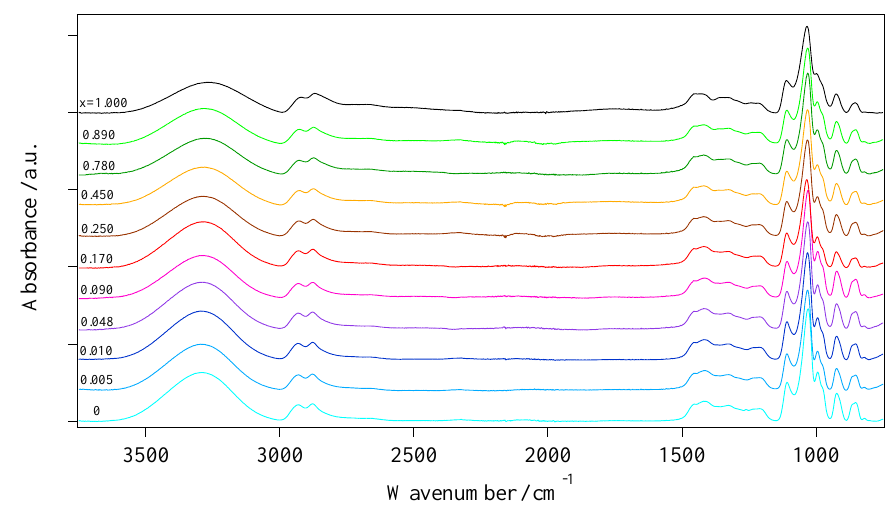
Figure 3. FT-IR spectra of GlyLi x electrolytes. Table 2. FT-IR and Raman correlational assignments of glycerol (Gly) and lithium glycerolate (GlyLi) samples. Glycerol, Gly (x = 0) Lithium Glycerolate, GlyLi (x =